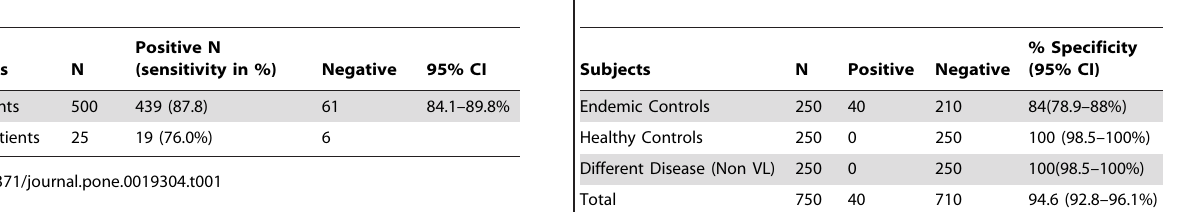
Table 1. Sensitivity of the PCR assay in confirmed VL cases. Table 2. Comparative specificity in different control